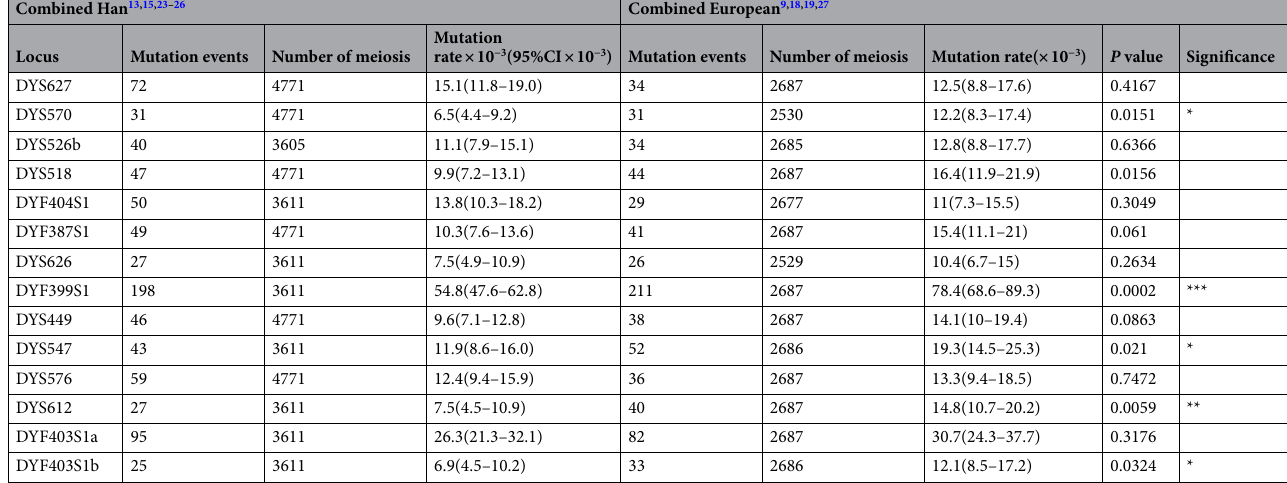
Table 2. The mutation rates of 14 RM Y-STRs in combined Chinese and European populations.